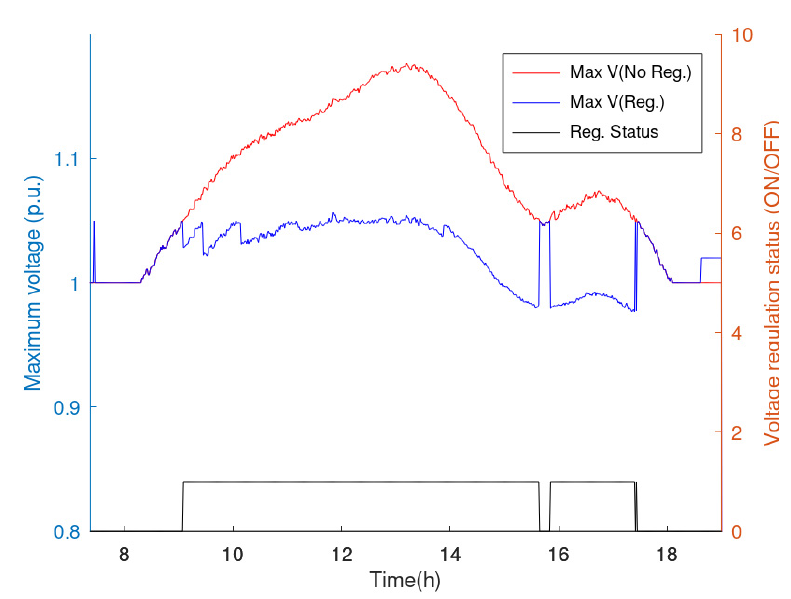
Figure 7 Case study voltage regulation. Figure 7. Case study voltage regulation.